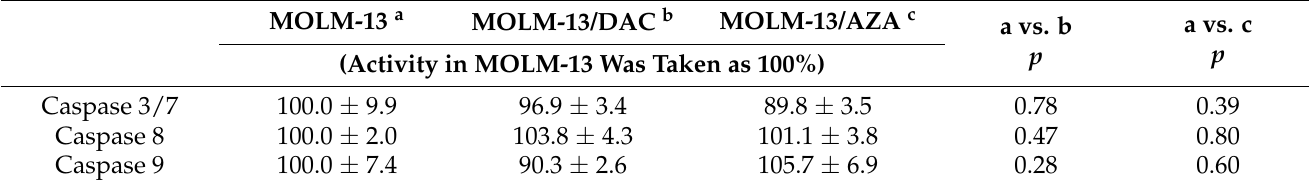
Table 2. Activity of the caspases in the parental and two resistant variants of MOLM-13 cells.